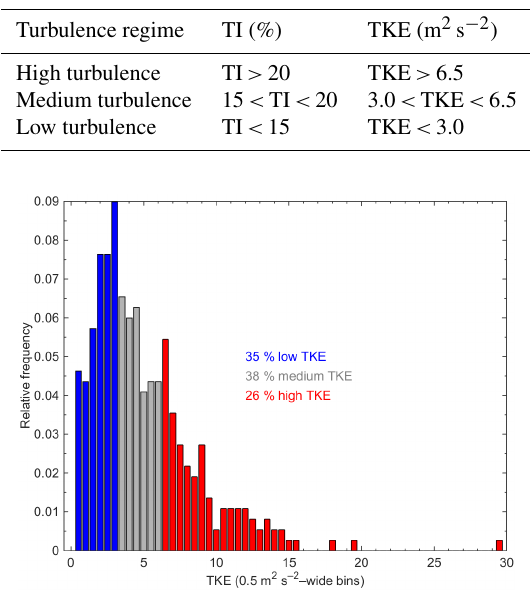
Table 3. Defined turbulence regimes.